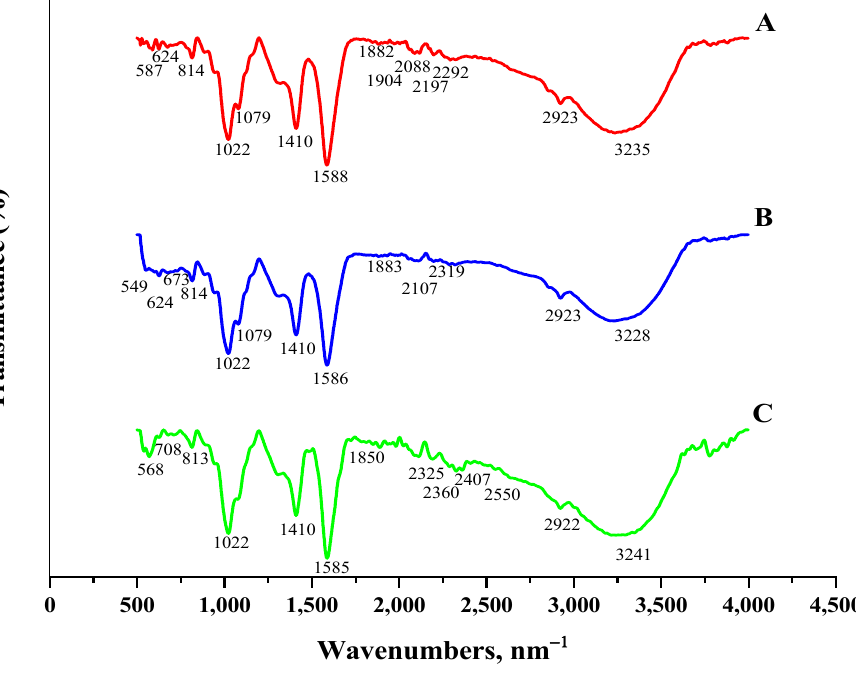
Figure 4. FTIR spectra of ( A ) CABs, ( B ) AVCABs, and ( C ) AVMNCABs before adsorption.